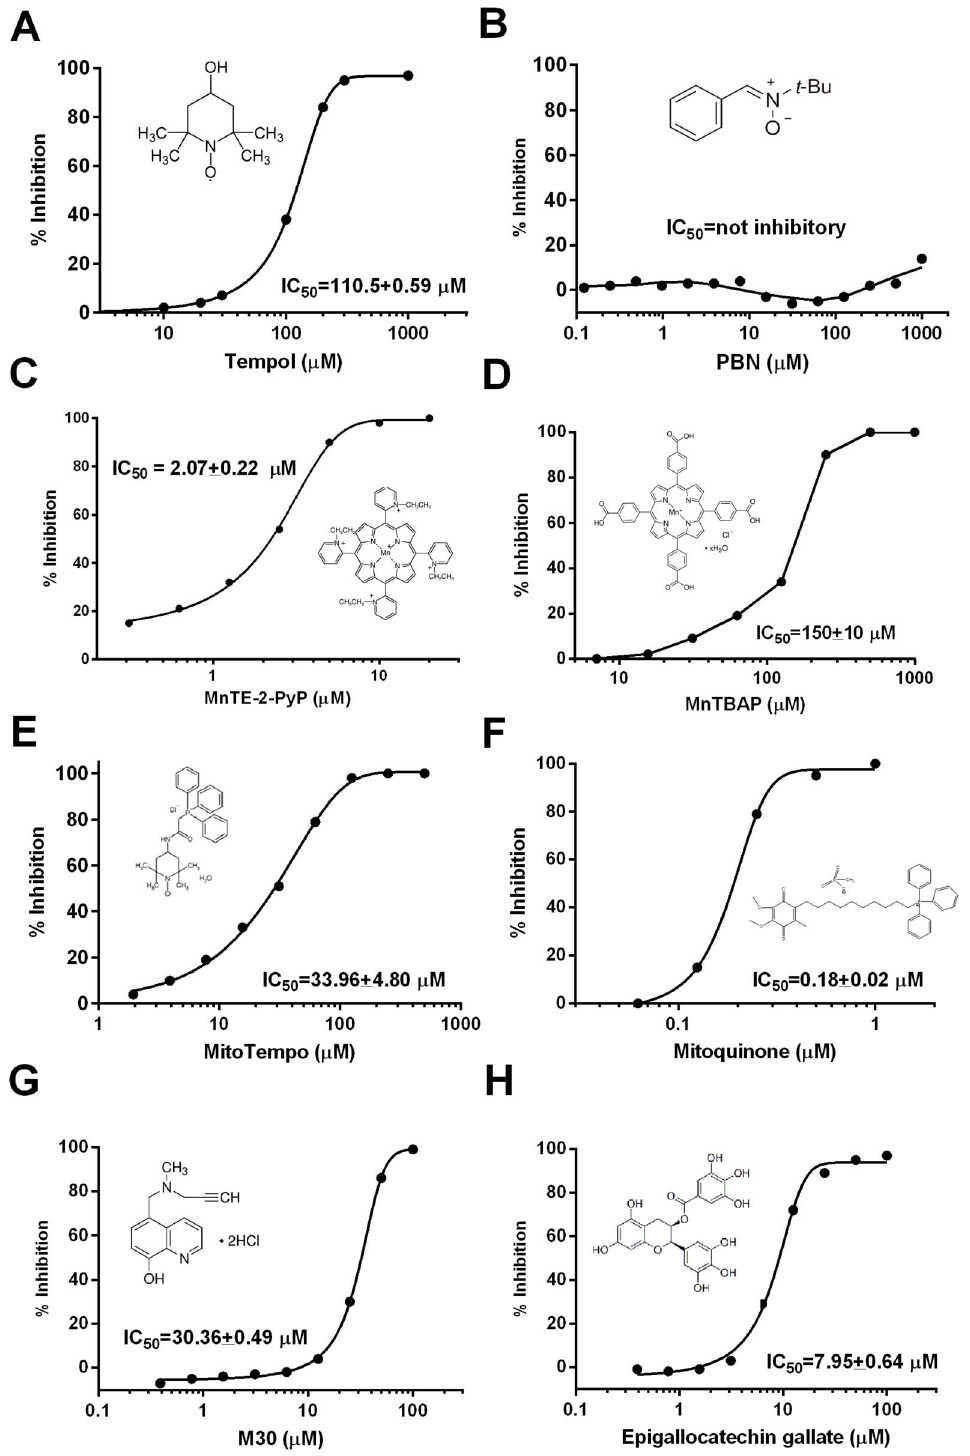
Figure 4. Tempol blocks parasite growth in vitro. Comparison with other antioxidants. A, Tempol; B, PBN; C, MnTE-2-PyP; D, MnTBAP; E , Mitotempo; F , Mitoquinone; G , M30; and H, Epigallocatechin gallate were added at the indicated concentrations directly to P. falciparum cultures containing trophozoite-stage parasites. After 48 hours of culture, the respective number of trophozoites present in the cultures was determined by pLDH (growth inhibition assay). Stock solution for all reagents was diluted in the culture assay media, or as specified in Materials and Methods. The chemical structure of each compound, and the corresponding IC 50s , are shown as an inset.